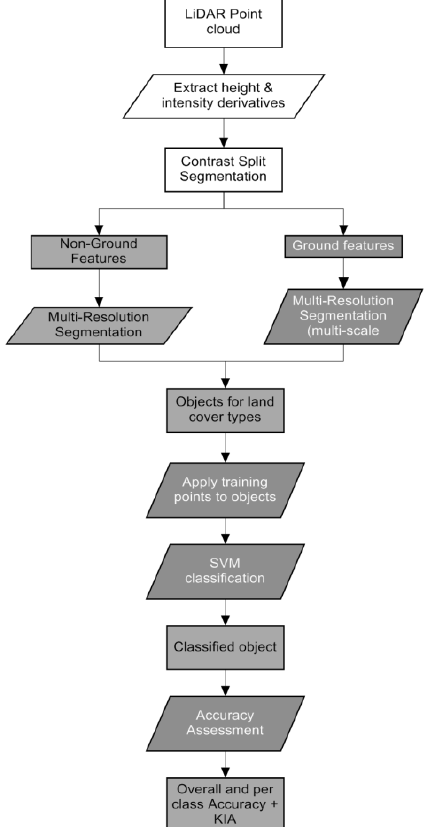
Figure 1. General Flowchart of LiDAR Data Classification